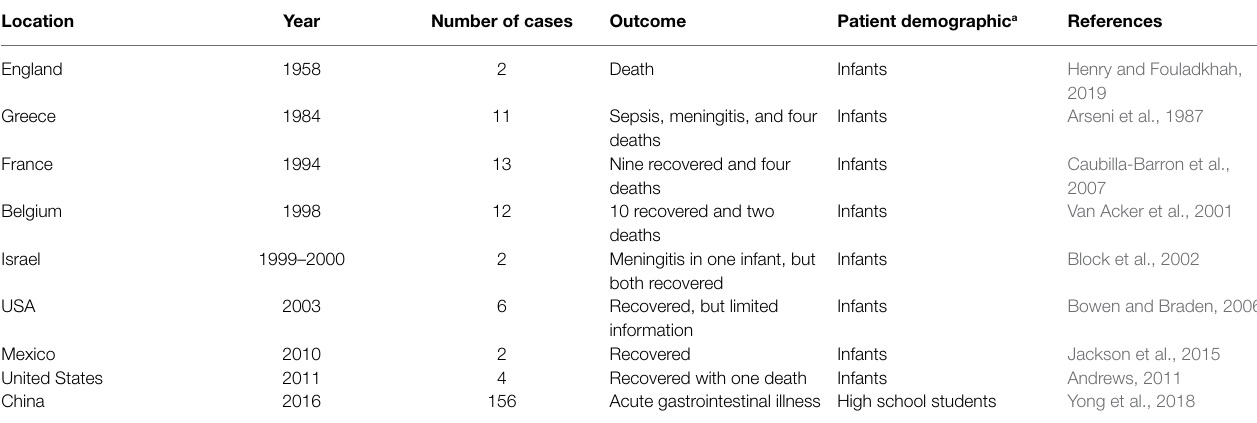
TABLE 2 | Summary of select global outbreaks of C. sakazakii occurring between 1958 and